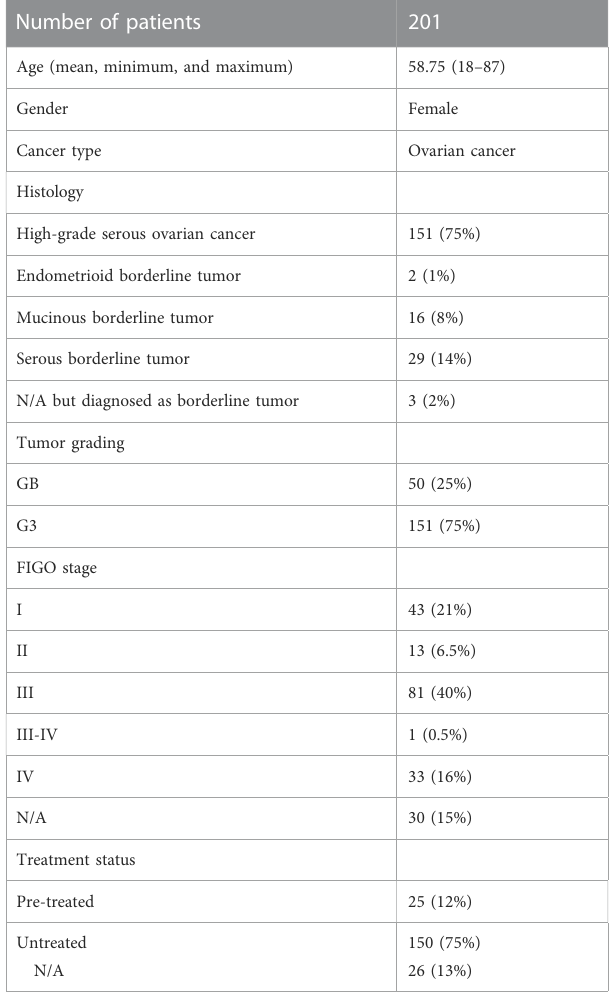
TABLE 1 Summery of patient